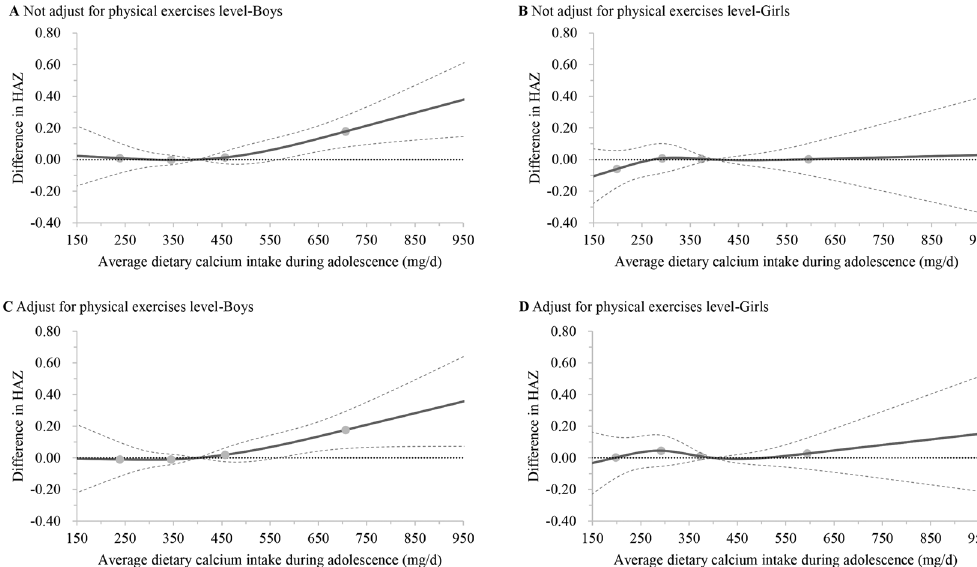
Figure 4. Multivariable adjusted dose-response associations between average dietary calcium intake during adolescence and HAZ from adolescence to young adulthood in boys and girls with plant-based diet. Multivariable adjusted dose-response curves were indicated by solid line and 95% confidence interval by dashed lines. Calcium intake were coded using an RCS function with four knots, represented by dots, located at the 5th, 35th, 65th, and 95th percentiles of the distribution of average intake of dietary calcium. Y-axis represents the difference in height-for-age z -score between individuals with any value of calcium intake with